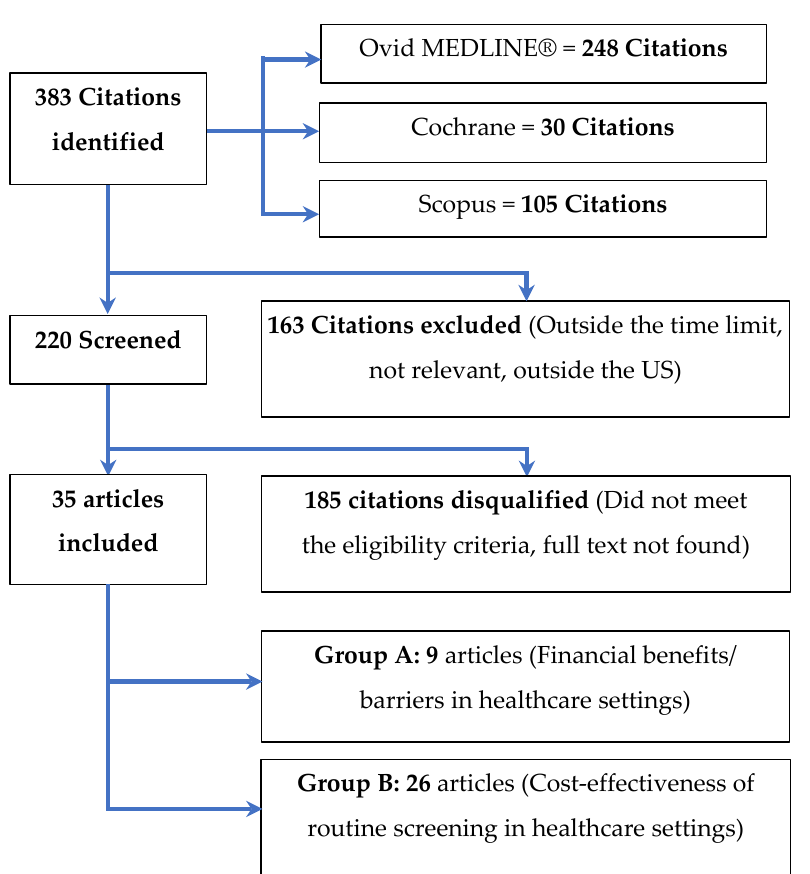
Figure 1. The selection process for articles included in the scoping review.